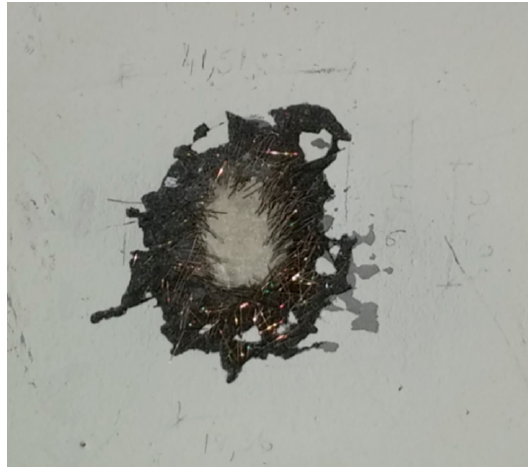
Figure 14. Damage surface.